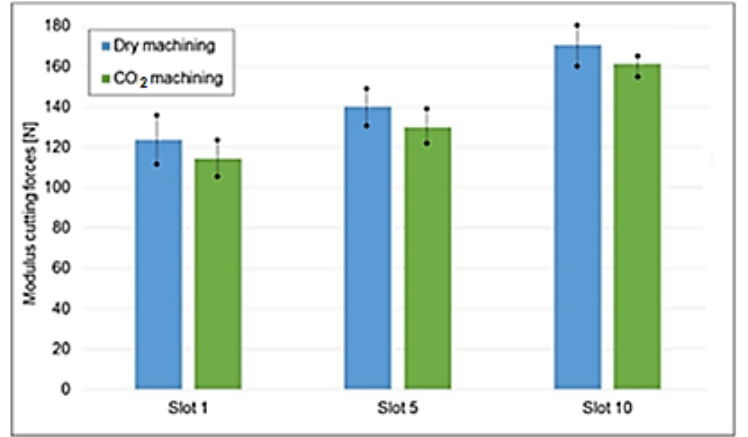
Figure 13. Comparison of modulus of cutting force for end milling Glass Fiber Reinforced Polymer (GFRP) composites in dry and liquid CO 2 cutting conditions [131]. Reproduced with permission from Springer.